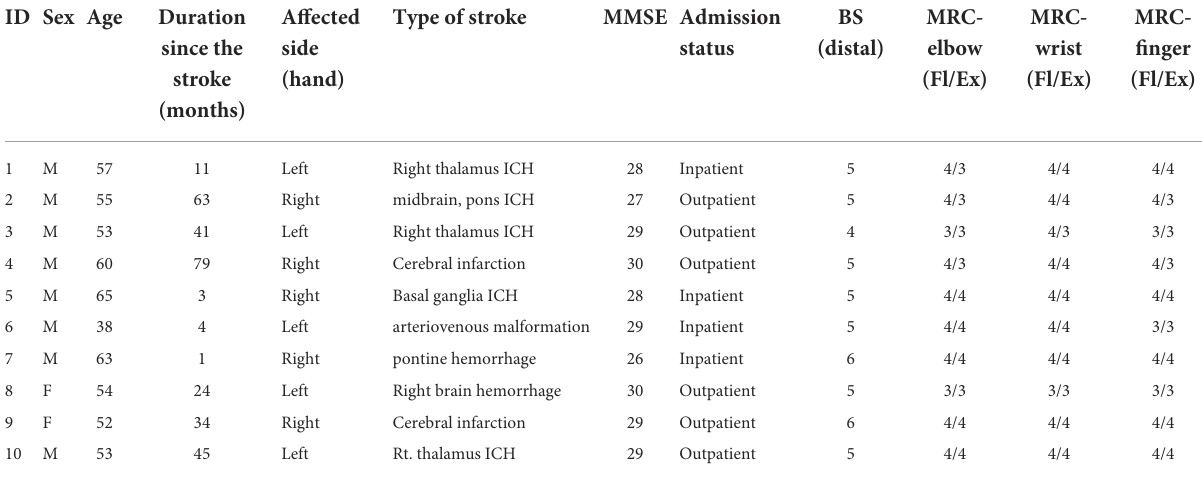
TABLE 1 Demographic and clinical characteristics of the